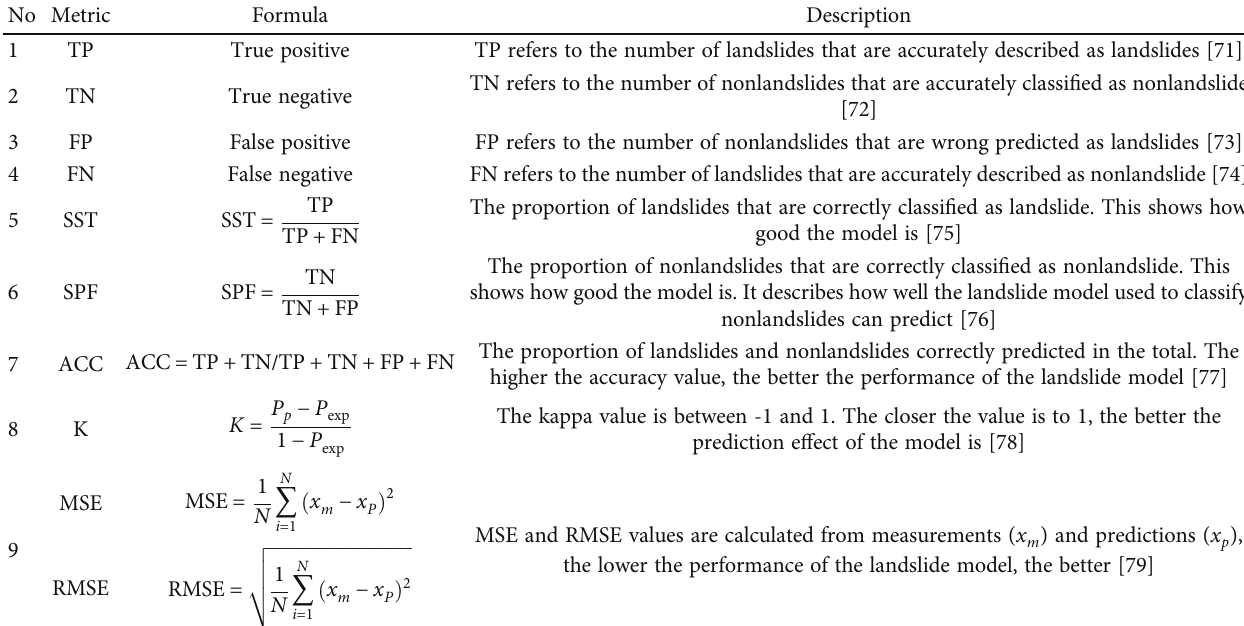
Table 3: Statistical metrics and their descriptions.